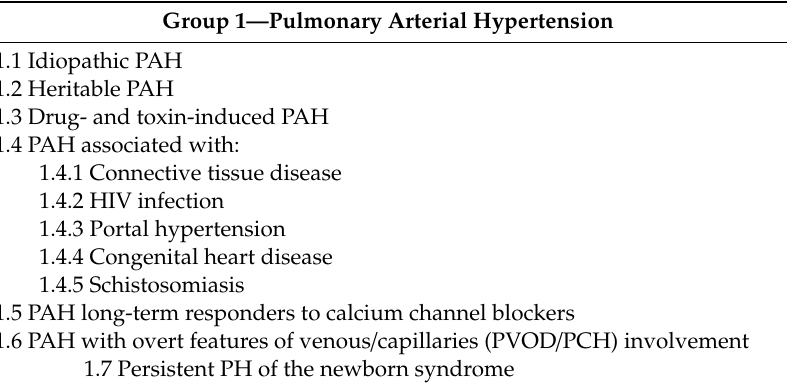
Table 1. Classification of pulmonary hypertension Group